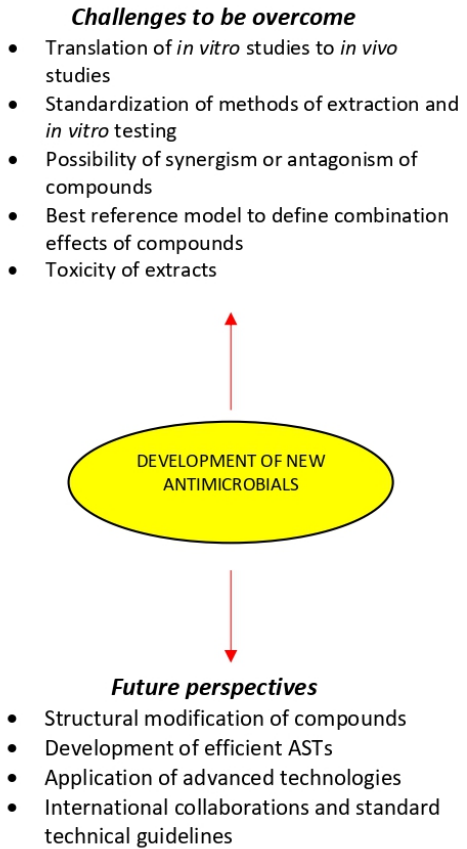
Figure 3. Medicinal plants in the development of new antimicrobials.